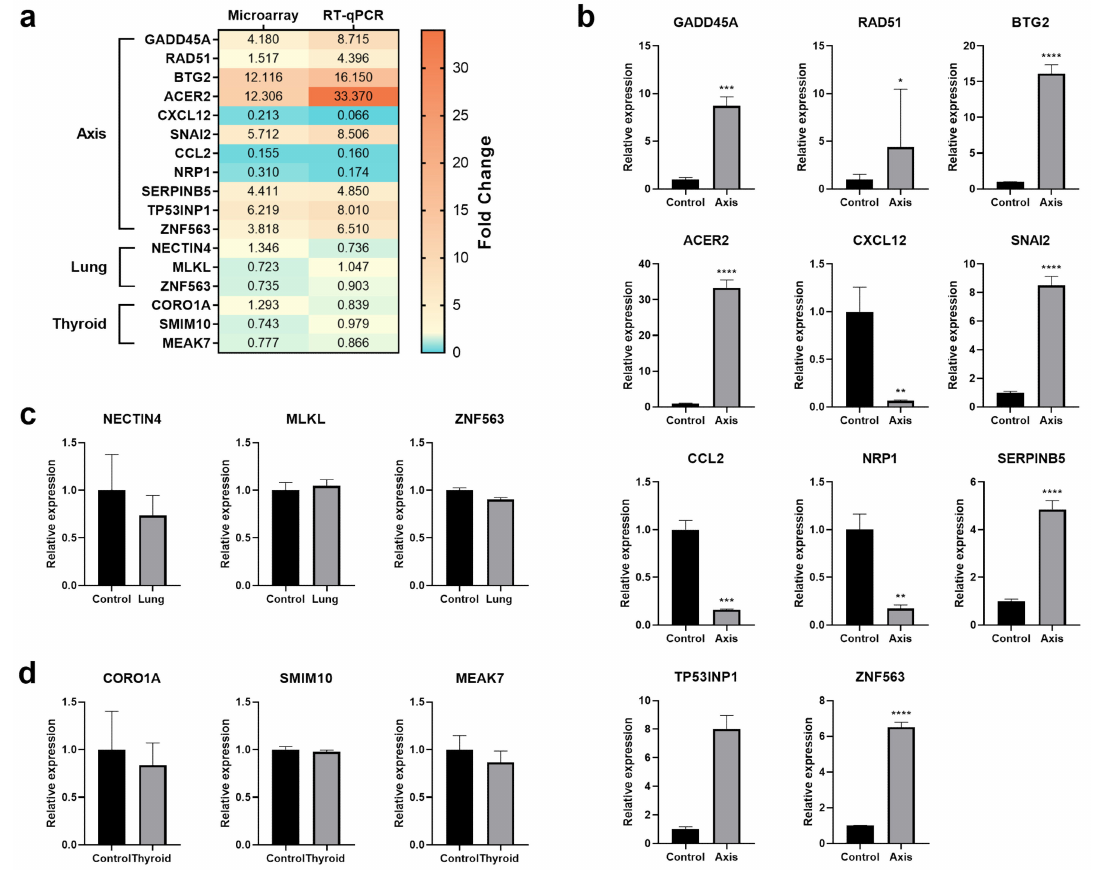
Figure 10. Real-time qPCR validation of microarray data. ( a ) Heat map showing fold change expression of chosen genes, measured with microarray and RT-qPCR; ( b ) The expression of selected genes in cells irradiated in the prostate (axis) measured using the RT-qPCR technique; ( c ) The expression of selected genes in cells irradiated in lung measured using the RT-qPCR technique; ( d ) The expression of selected genes in cells irradiated in thyroid measured using the RT-qPCR technique. The graphs represent means ± SD from three biological replicates. *— p < 0.05, **— p < 0.01, ***— p < 0.001, ****— p < 0.0001, based on Student’s t